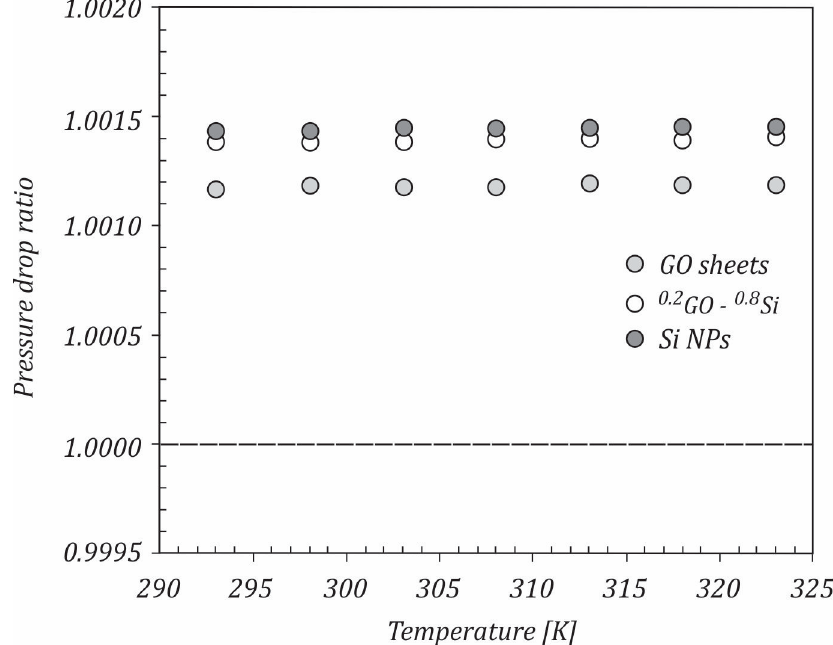
Figure 12. The variation of the pressure drop ratio with temperature.